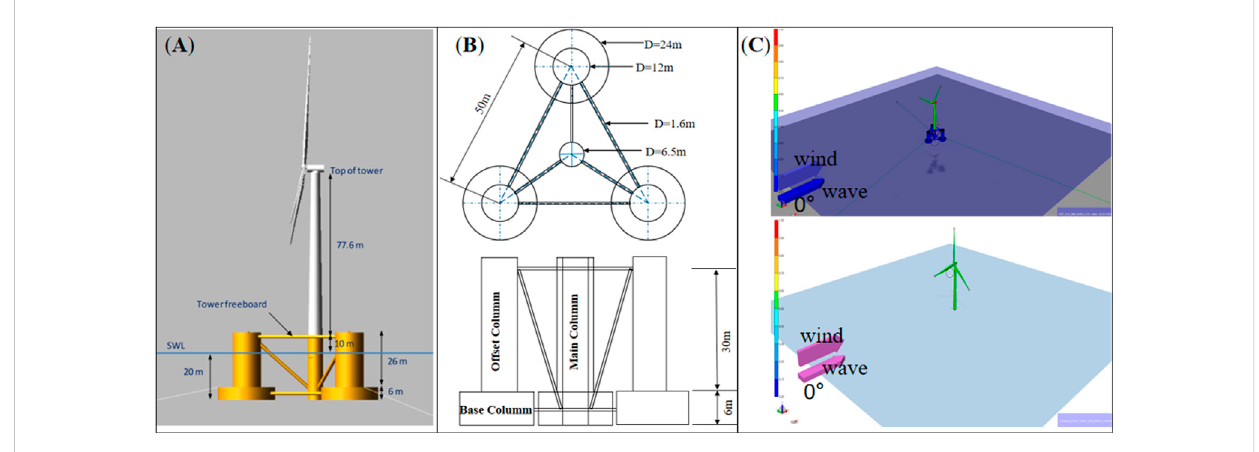
FIGURE 2 (A) GlobalviewoftheFOWT. (B) DetailsoftheFOWTs ’ substructure(Robertsonetal.,2014). (C)